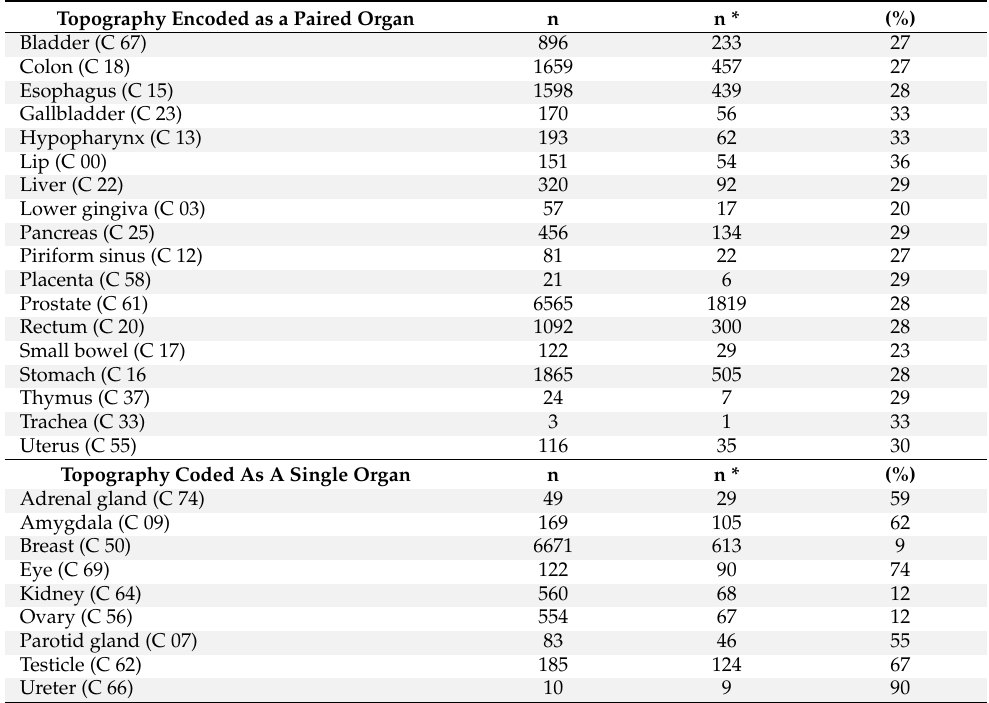
Of the total cancer registries, 4.49% ( n = 5428) showed inconsistencies between the information “topography” and “tumor laterality”. Among the topographies that presented valid laterality, those that had the highest percentage of proportional filling error in relation to the total of their topography were: “ureter” (90%), “eye” (74%), “testicle” (67%), “amyg- dala” (62%), “adrenal gland” (59%), and “parotid gland” (55%). Additionally, among the topographies that did not have laterality, those with the highest percentages of errors were: “lips” (36%), trachea” (33%), “gallbladder” (33%), “hypopharynx” (33%), “uterus” (30%), “liver” (29%), “pancreas” (29%), “placenta” (29%) and “thymus” (29%) (Table 5). Table 5. Inconsistency between topography and laterality, HCR/ES 2010–2017. Topography Encoded as a Paired